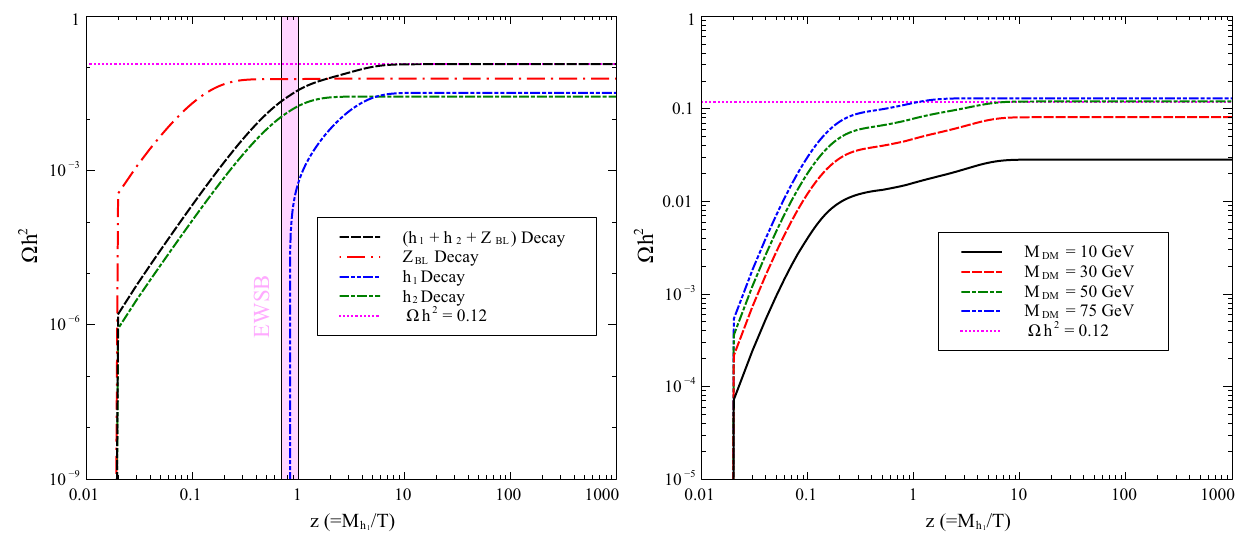
Fig. 9 Left panel: variation of decay contributions of the two Higgs bosons to (cid:9) h 2 separately with z . Right panel: Variation of relic density (cid:9) h 2 with z for different values of the DM mass M